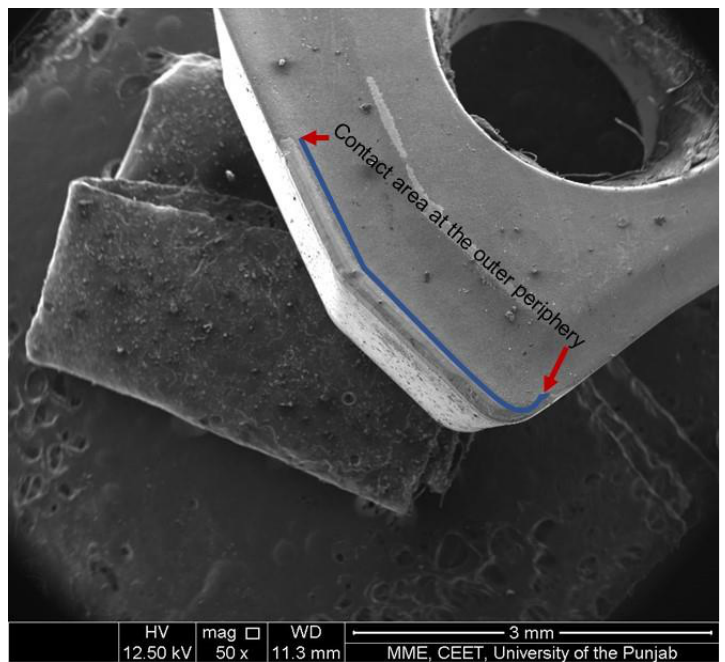
Figure 8. Chips produced during the experiment at ( a ) the start of drilling Test 9 and ( b ) the test cessation of Test 9.